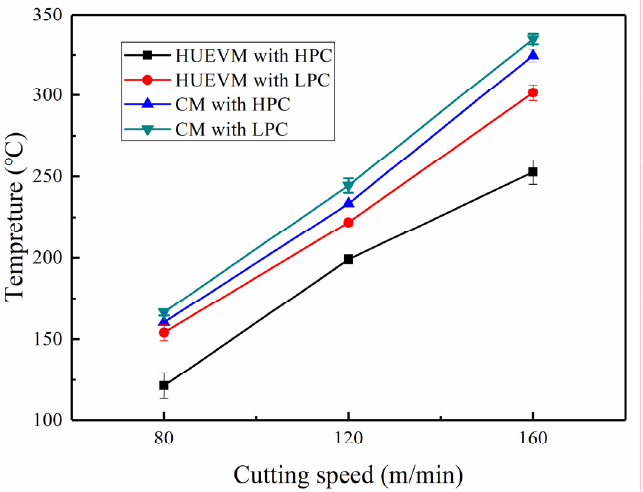
Figure 10. Relationship between the temperature and cutting speed at different cooling conditions.